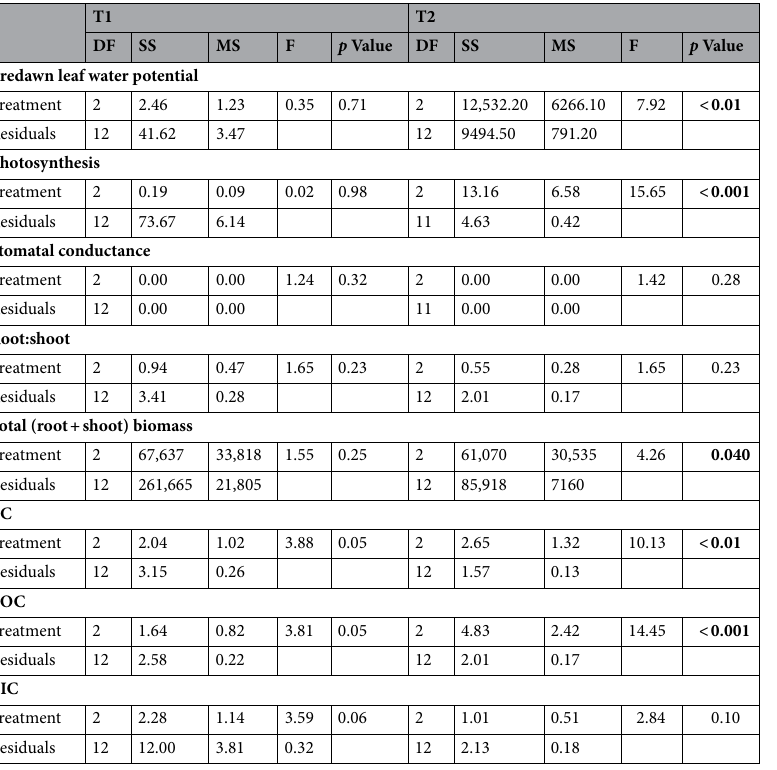
Table 1. ANOVA tables identifying significant differences between treatment means before (T1) and after treatment (T2) for each physiological response variable (predawn leaf water potential, photosynthesis, stomatal conductance, root to shoot biomass ratio (root:shoot), root exudate total C (TC), root exudate total organic C (TOC), root exudate total inorganic C (TIC), total (root + shoot) biomass). DF degrees of freedom, SS sum of squares, MS mean square, F F-statistic, p value. Bold values indicate p <